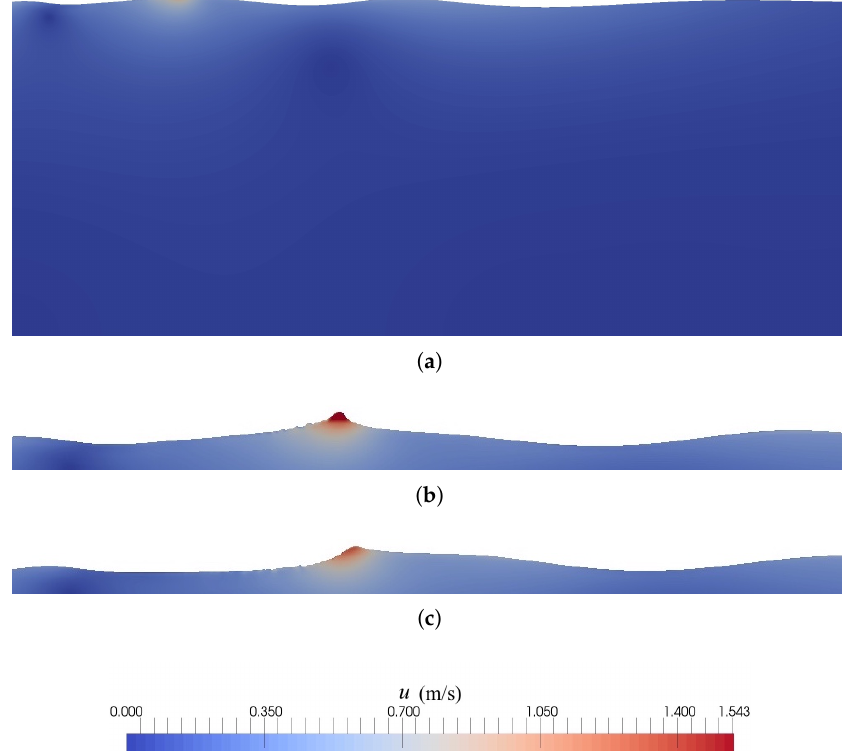
Figure 10. Snapshots of numerically reconstructed steep irregular wave propagating in deep water in side view at ( a ) t = 38.37 s; ( b ) t = 38.37 s (zoomed around the free surface); ( c ) t = 38.69 s (zoomed around the free